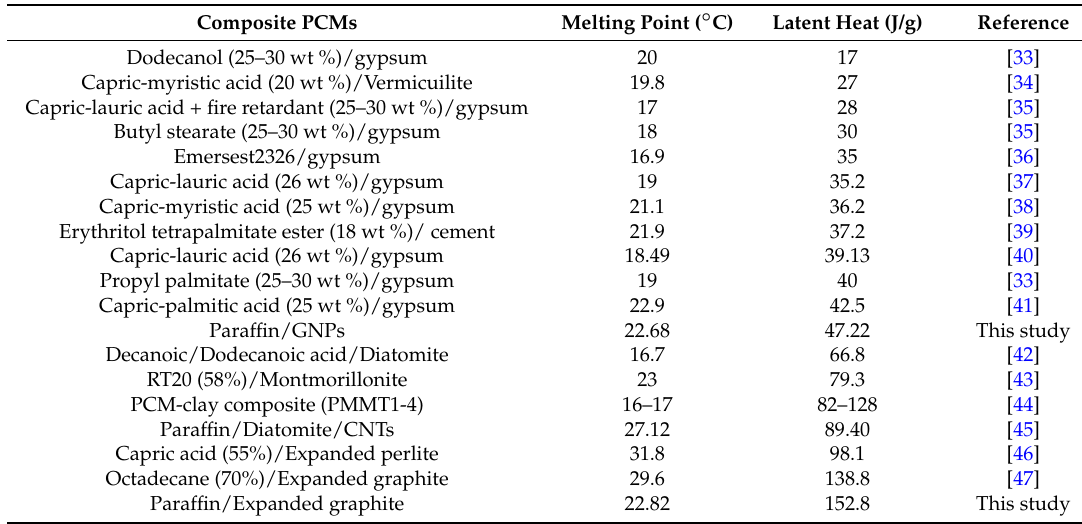
Table 3. Thermal properties comparison of composite PCMs with phase change temperature in the human comfort zone.